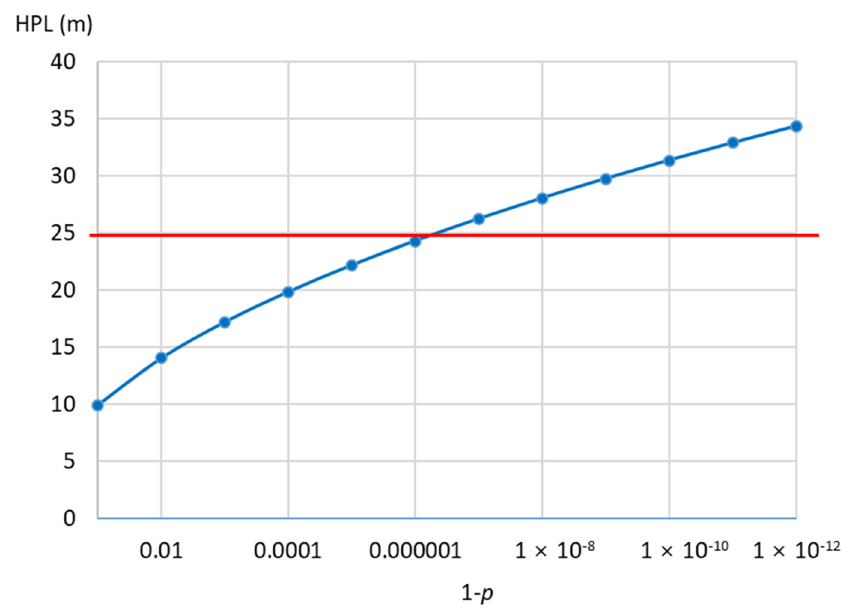
Figure 8. Dependence of HPL specified for 8 m 95% accuracy on its probability level p (logarithmic